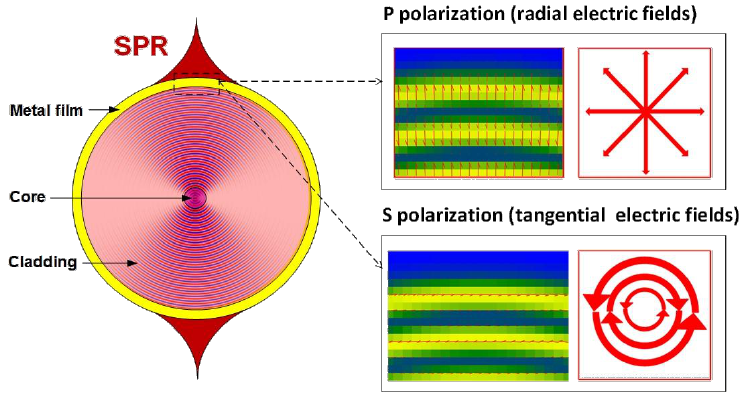
Figure 7. Sketch of the surface plasmon resonance (SPR) excitation around an optical fiber showing the required polarization of the electric field.